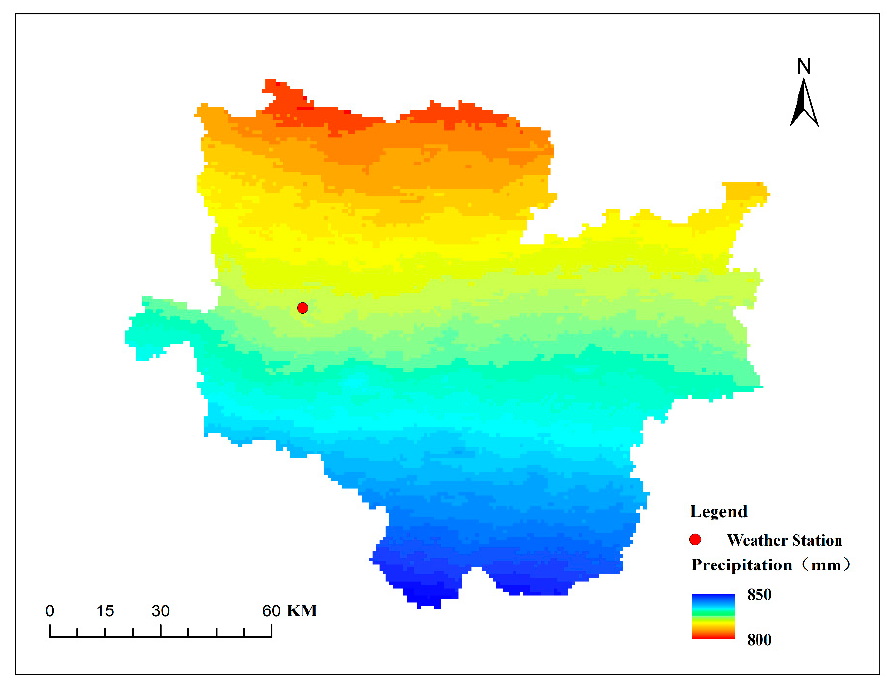
Figure 3. Annual average precipitation distribution in the study area from 1978 to 2022.